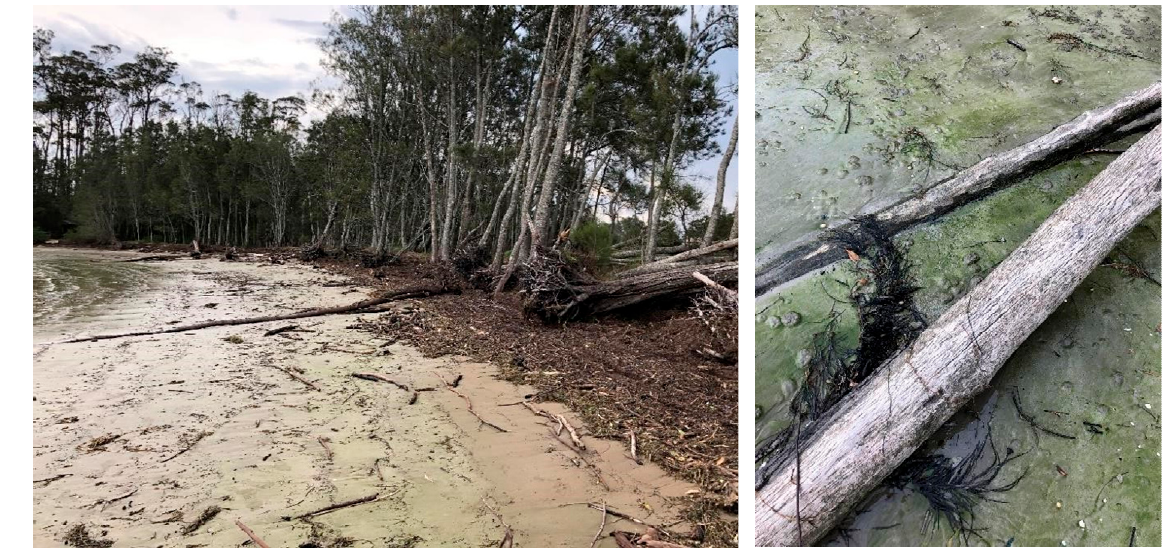
Figure 9. Trees knocked over due to an ECL event ( left ) and the presence of algal blooms ( right ), with the photos having been taken on 2020-02-12 at 35.7144° S, 150.1795° E.